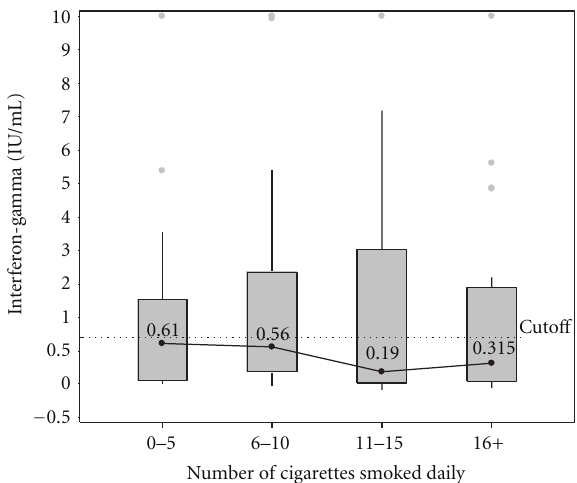
Figure 1: Median IFN- γ and interquartile range at 18 months by quartiles of number of cigarettes smoked. IFN- γ > 10 IU/mL were set to 10IU/mL due to imprecision at high concentration levels. The dotted line represents the 0.70 IU/mL cuto ff which was used to define QFT conversion. IFN- γ : interferon-gamma. QFT: QuantiFERON-TB Gold In-Tube.